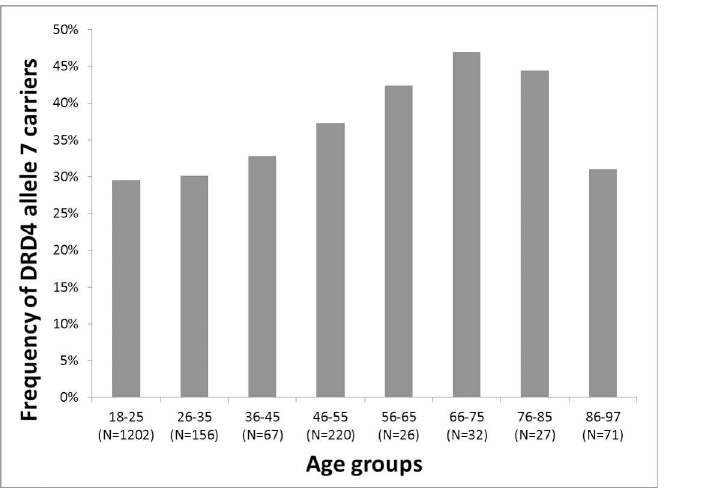
DRD4 VNTR genotypes 7 absent 7